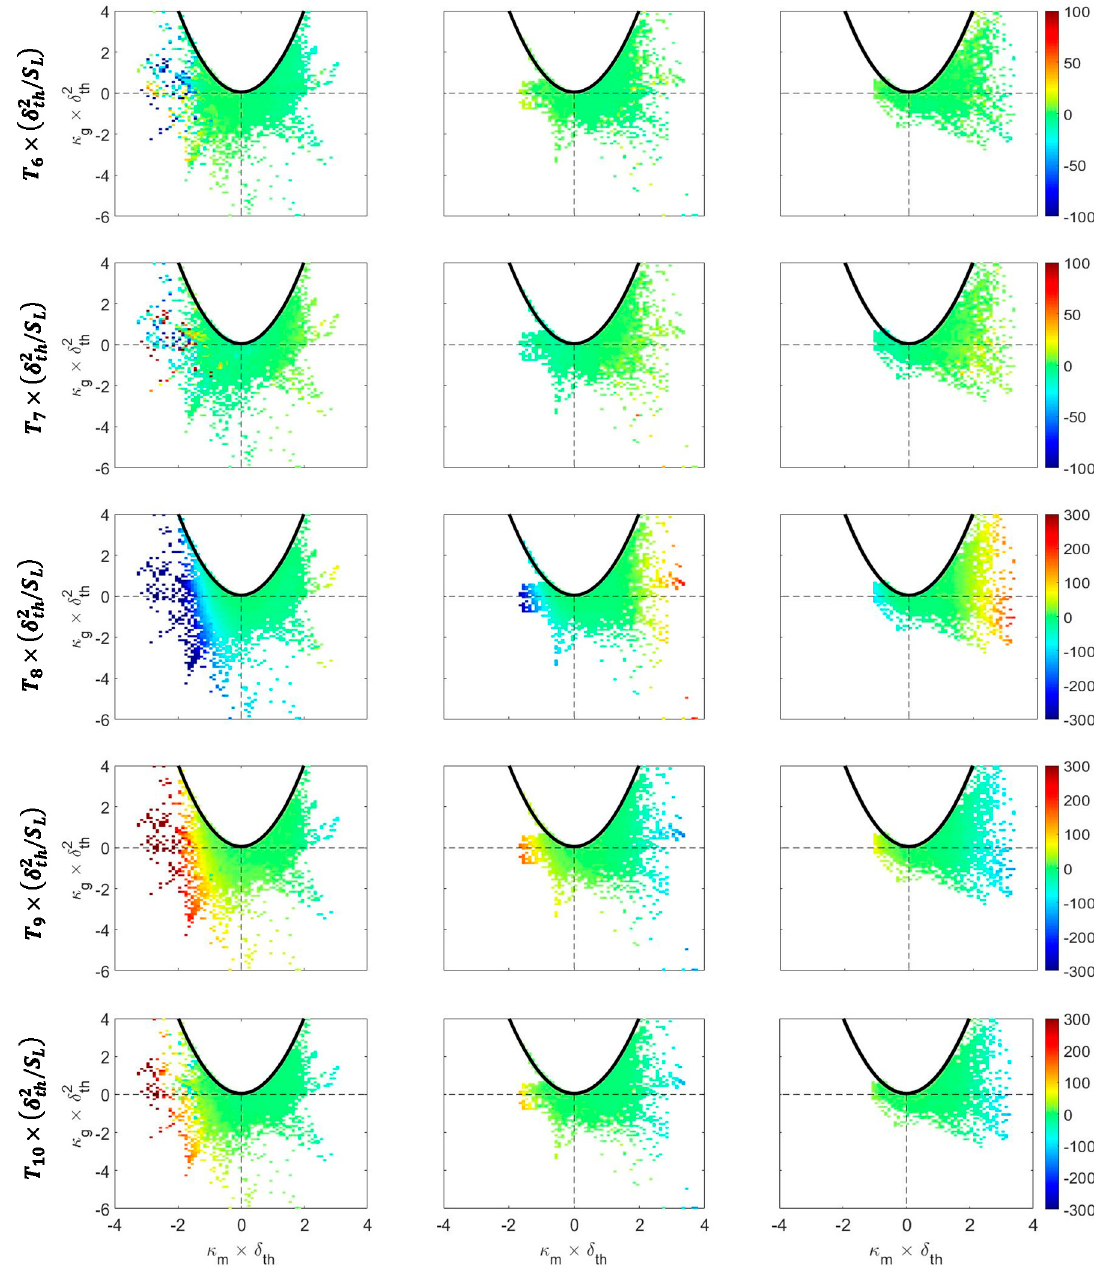
Figure 8. Variations of the mean values of T 6 − 10 × ( δ 2 / S L ) (1st–5th row) conditional on κ m × δ th and κ g × δ 2 for Le = 0.8, 1.0 and 1.2 flames (1st–3rd column) for c = 0.8 isosurface.